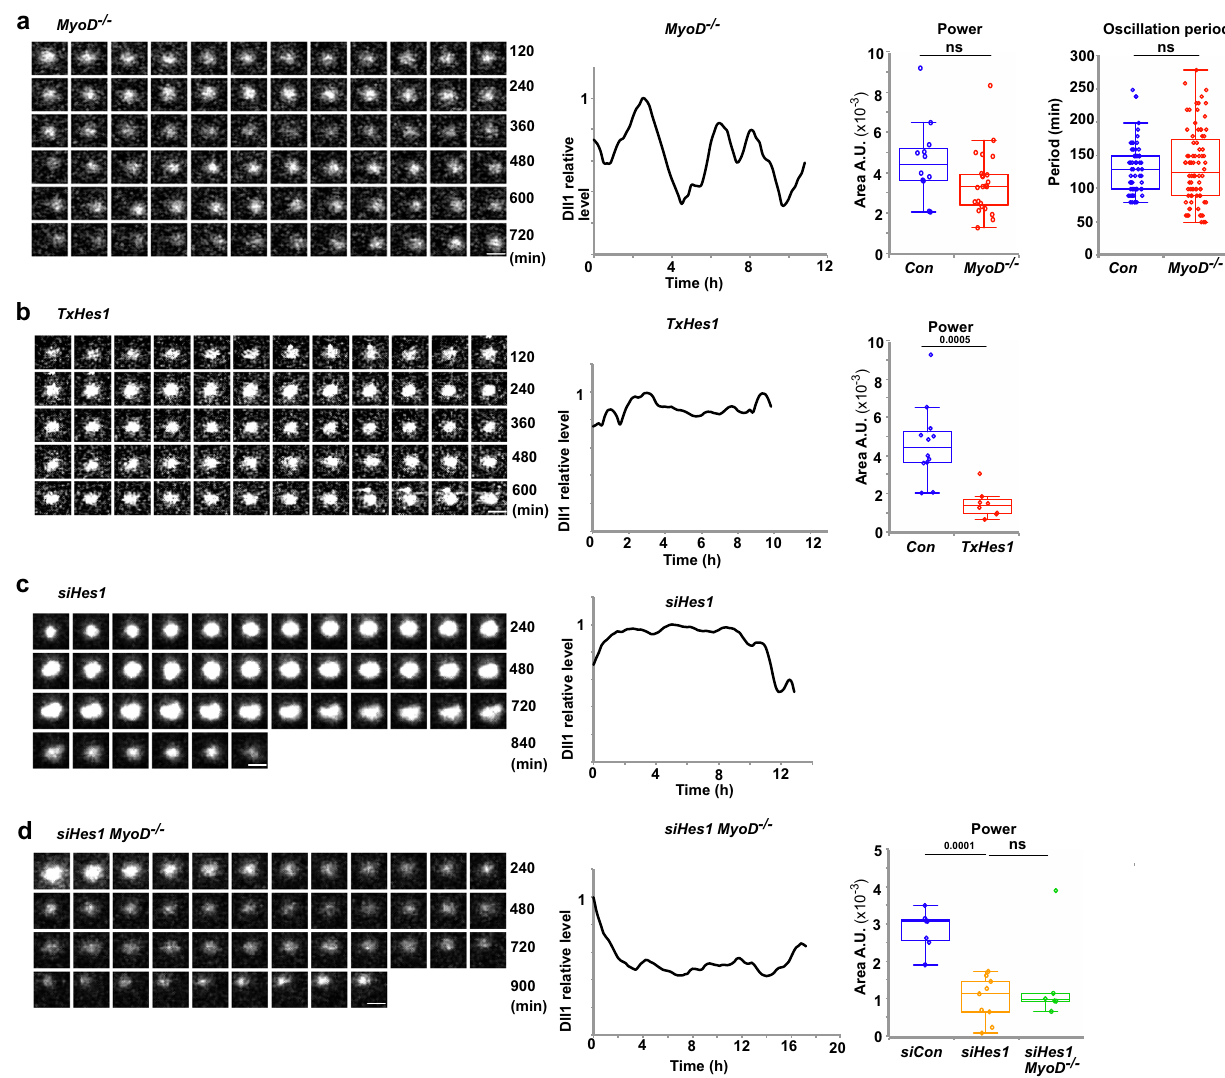
Fig. 4 Hes1 but not MyoD is required for the oscillatory expression of Dll1. a Bioluminescence signals from Dll1-luciferase observed in a single MyoD − / − mutant muscle stem cell associated with a myo fi ber and a quanti fi cation of this bioluminescence signal (left); the myo fi ber and associated stem cell was isolated from a MyoD − / − ;Dll1 luc animal. Quanti fi cation of the oscillatory stability (power of the Fast Fourier transformation) and the oscillatory period in control and MyoD − / − cells (right); each point represents data obtained from a single imaged cell; n = 23 experiments. b Bioluminescence signals from Dll1- luciferase observed in a single Hes1 mutant muscle stem cell associated with a myo fi ber obtained from a TxHes1;Dll1 luc animal and quanti fi cation of this bioluminescence signal (left). Quanti fi cation of the oscillatory stability (power of the Fast Fourier transformation) in control and Hes1 mutant cells (right); n = 8 experiments. c Bioluminescence signals from Dll1-luciferase observed in a single muscle stem cell associated with a myo fi ber treated with siHes1 RNA and quanti fi cation of this bioluminescence signal. The myo fi ber and associated muscle stem cell were isolated from a Dll1 luc animal. d Bioluminescence signals from Dll1-luciferase observed in a single muscle stem cell associated with a fi ber and quanti fi cation of this bioluminescence signal (left); the fi ber and associated stem cell were derived from a MyoD − / − ; Dll1 luc animal and treated with siHes1 RNA. Quanti fi cation of the oscillatory stability (power of the Fast Fourier transformation) in siRNA control ( n = 5 experiments) and siHes1 RNA ( n = 9 experiments) treated wild-type cells, and siHes1 RNA treated MyoD − / − ( n = 6 experiments) mutant cells (right). In the box plot, center lines show the medians; box limits indicate the 25th and 75th percentiles; whiskers extend 1.5 times the interquartile range. Scale bars, 15 μ m. Exact p values are indicated, ns indicates P > 0.05, unpaired two-sided t